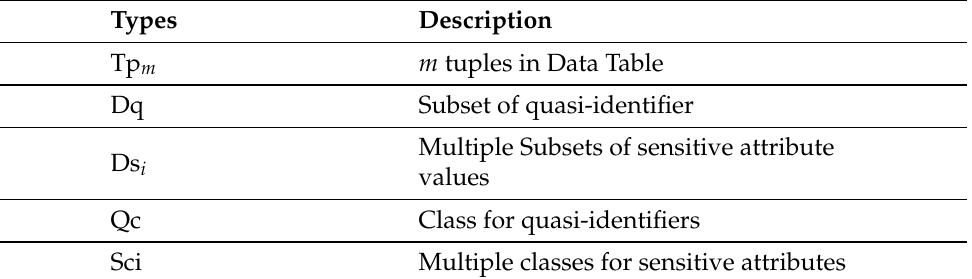
Table 7. Types used in HLPN for F-Classify